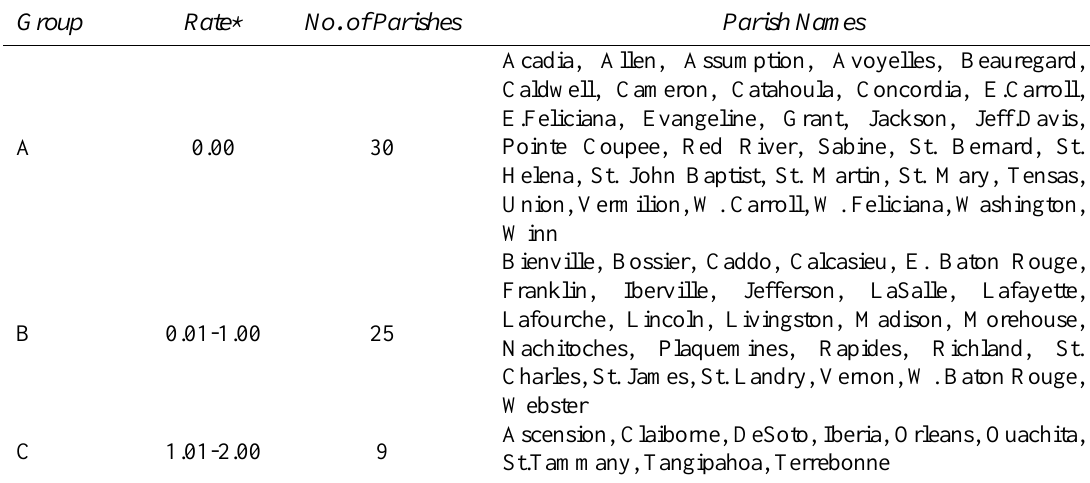
Table 9: Distribution of shigella in various parishes for the year 2000.